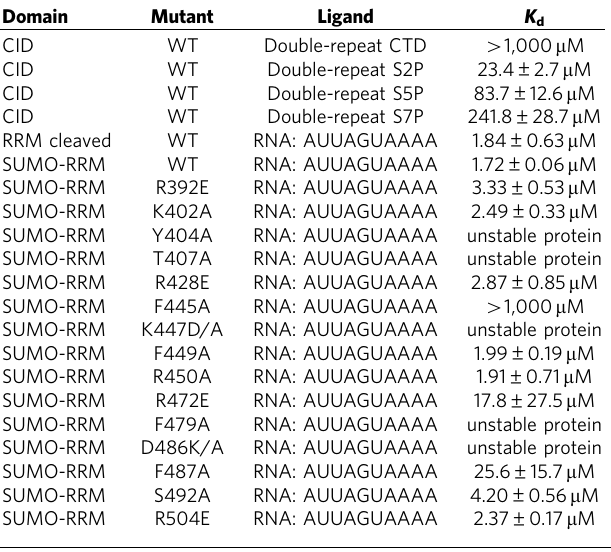
Table 1 | K d values of CID–CTD and RRM–RNA interactions.